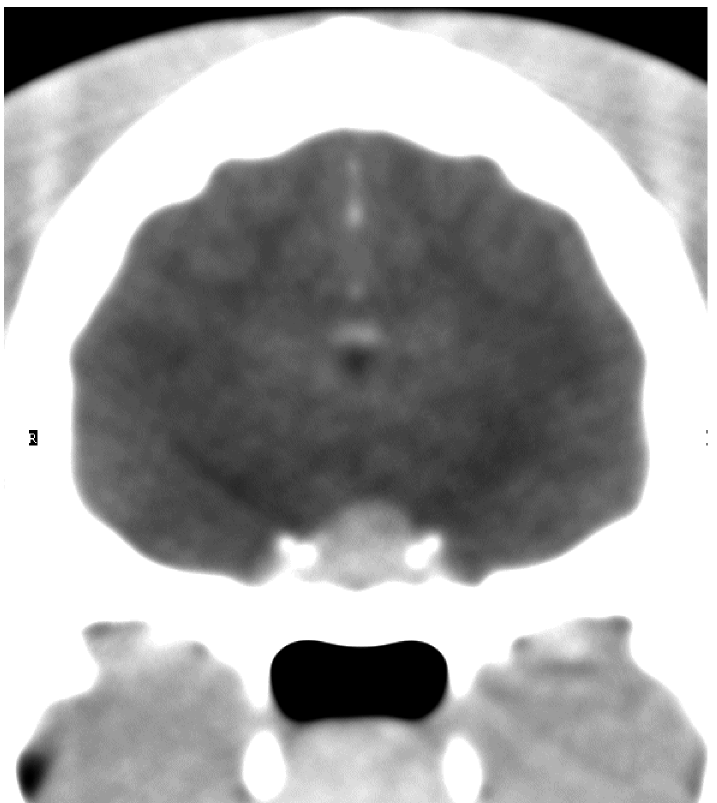
Fig 1. Protrusion of the pituitary beyond the dorsal rim of the sella turcica. This figure shows an example of a transverse, post-contrast CT image in a cat with HS. In this instance the dorsoventral dimension (height) of the enlarged pituitary was